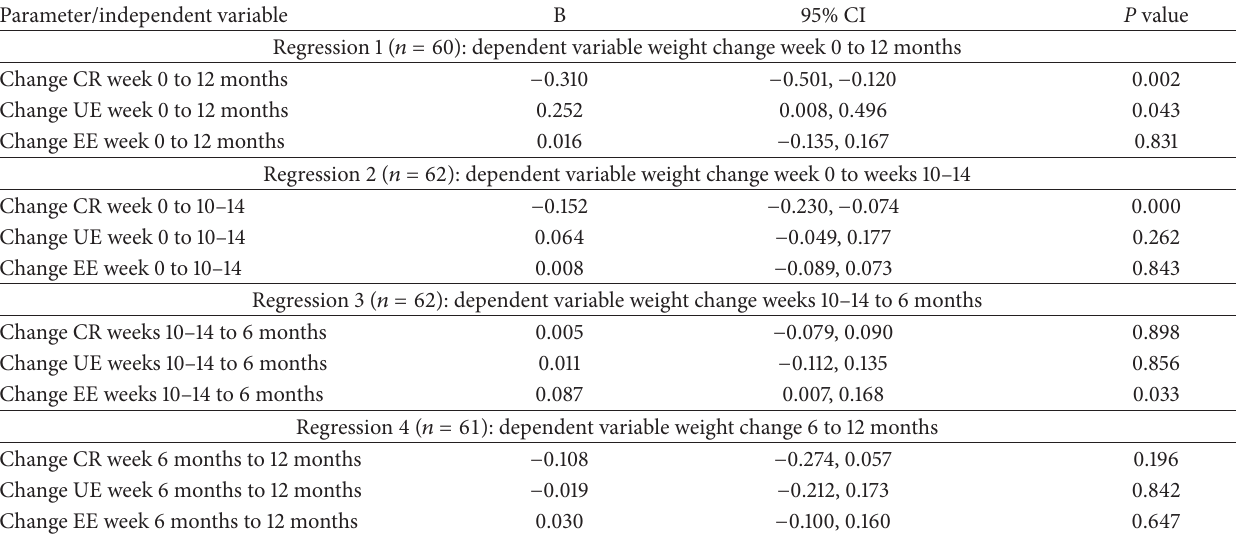
Table 8: Univariate GLM between changes in eating behavior and weight